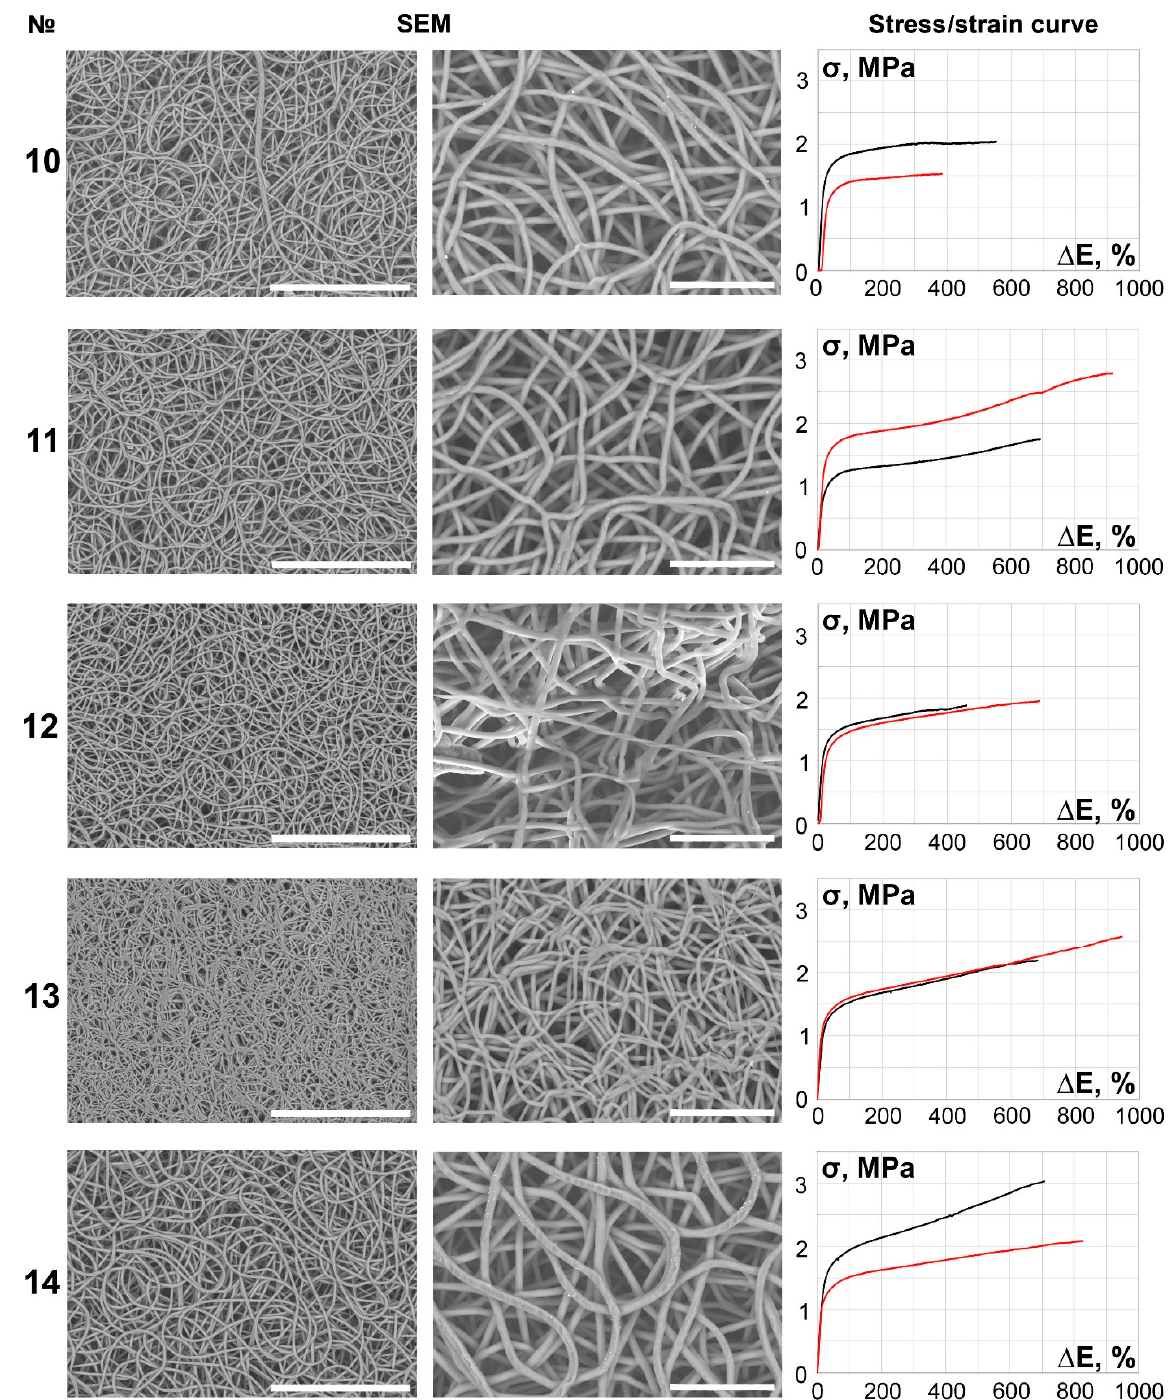
Figure 3. SEM images (×250 magnification, scale bar 200 µm and ×700 magnification, scale bar 50 µm) and stress/strain curves of tested 10% PCL samples. Red curves reflect stress/strain plotting in the axial direction; black curves correspond to circumferential stretching.